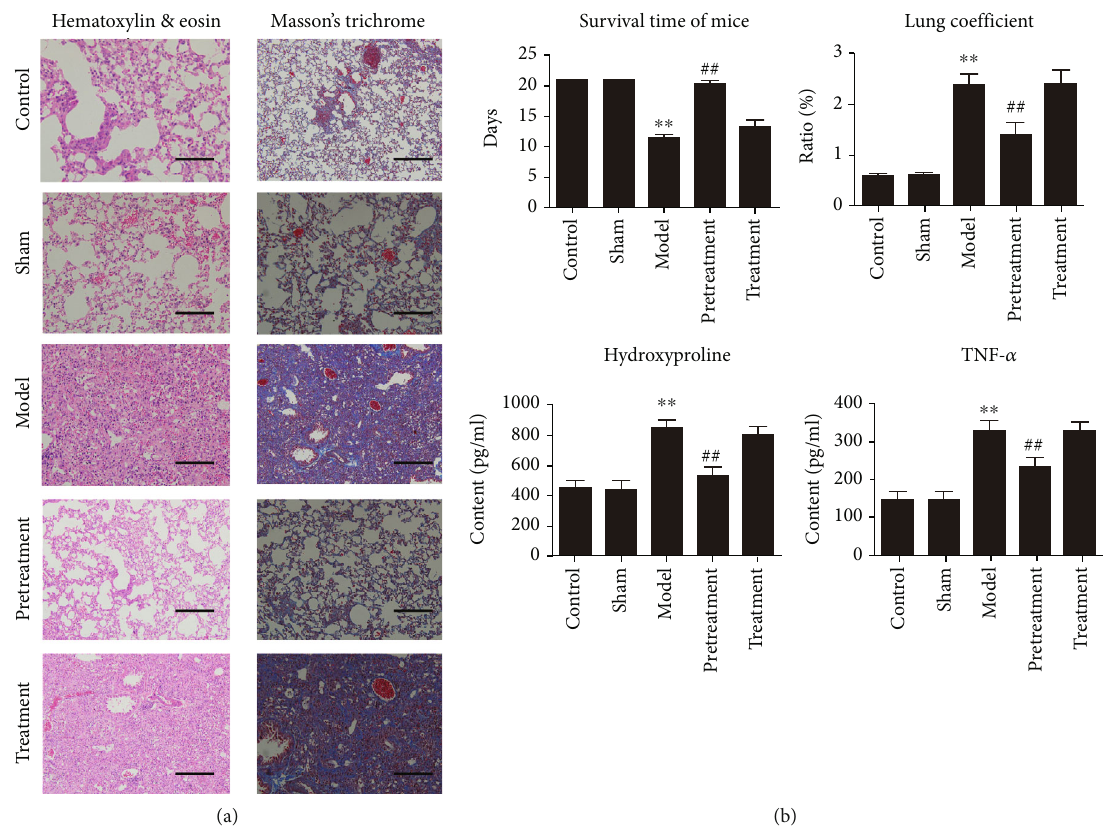
Figure 2: Analysis of several indexes in the evaluation of HUCMSC administration of bleomycin-induced pulmonary fi brosis in mice. (a) Results of HE and Masson staining in mouse lungs of the control, sham, model, pretreatment, and treatment groups. Scale bar = 100 μ m. (b) Results in the control, sham, model, pretreatment, and treatment groups. Data are presented as mean ± SEM . ∗ p ≤ 0 : 05 , ∗∗ p ≤ 0 : 01 vs. the control; # p ≤ 0 : 05 , ## p ≤ 0 : 01 vs. the